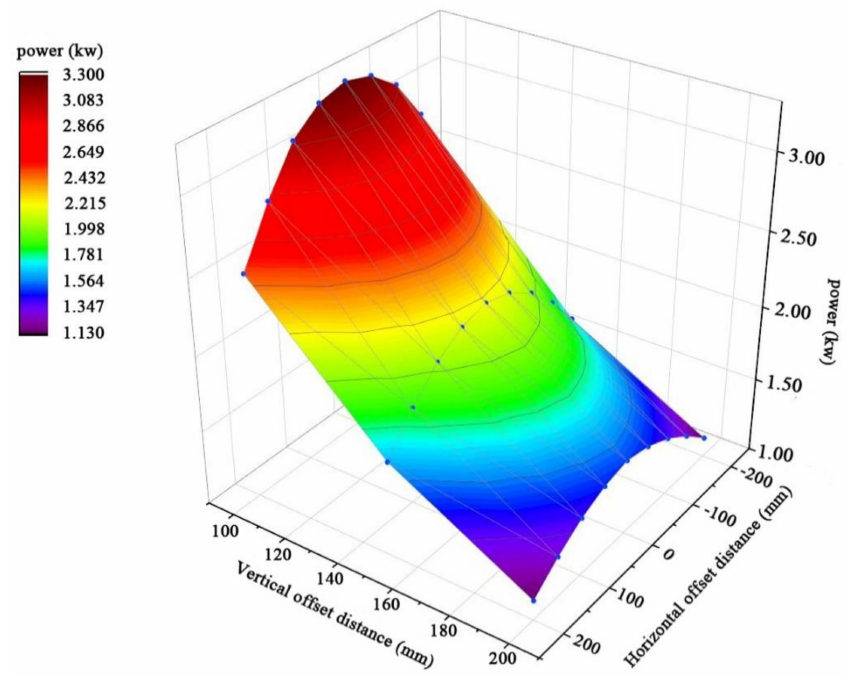
Figure 25. Variation diagram of system power with vertical misalignment distances offset perpendic- ular to the placement direction of the magnetic